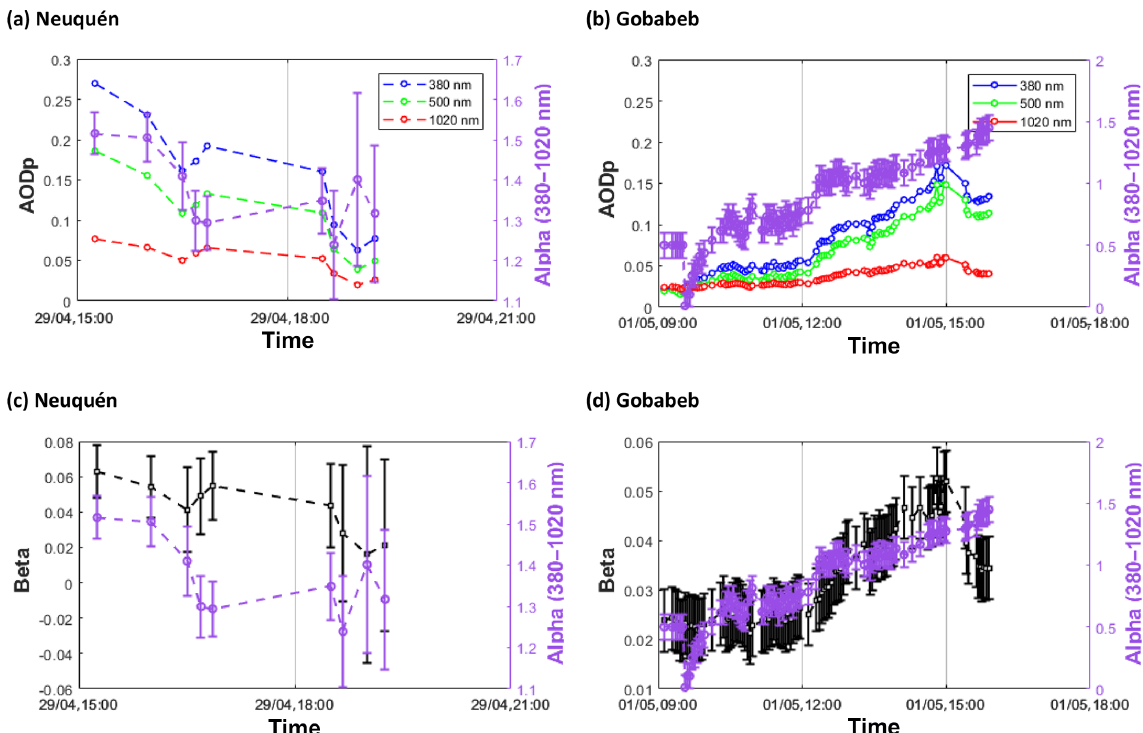
Figure 10. The time evolution of the plume-isolated AOD in the UV–NIR wavelength versus the Angström exponent (380–1020nm) (a) for 29 April over Neuquén and (b) for 1 May over Gobabeb. The time evolution of the Angström turbidity versus the Angström exponent (380–1020nm) (c) for 29 April over Neuquén and (d) for 1 May over